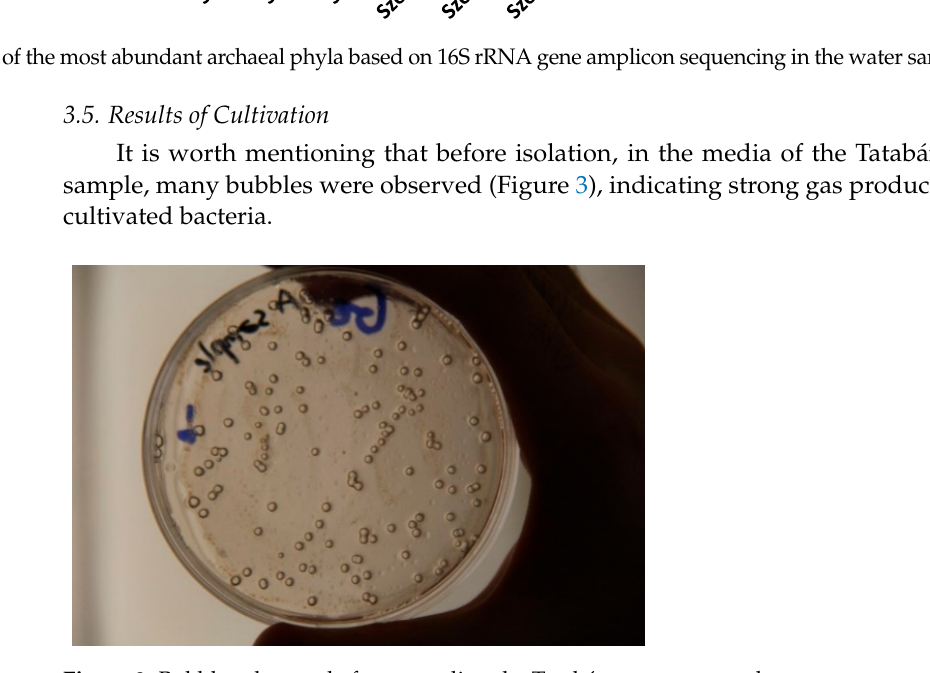
Figure 3. Bubbles observed after spreading the Tatabánya water sample.